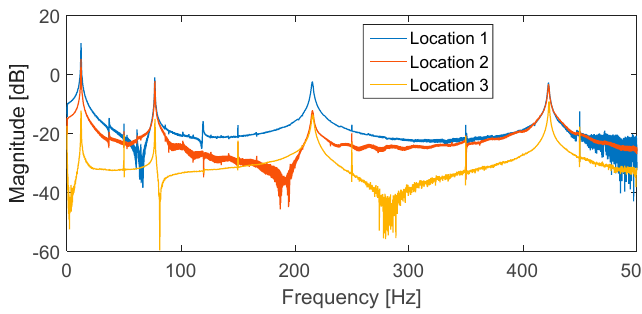
Sensors 2016 , 16 , 601 Figure 6. Frequency response functions for three impact locations. Figure 6. Frequency response functions for three impact locations. Table 2. Natural frequencies of the cantilever beam (Hz).